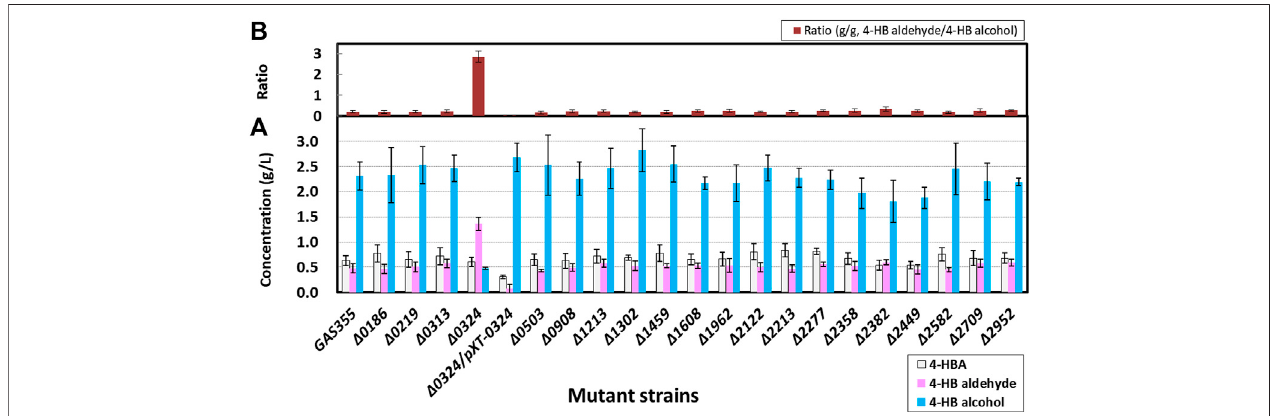
FIGURE 2 | Production of 4-hydroxybenzoate, 4-hydroxybenzaldehyde, and 4-hydroxybenzyl alcohol. (A) and the ratio of 4-hydroxybenzaldehyde to 4- hydroxybenzyl alcohol (B) by 20 in-frame deletion C. glutamicum mutants responsible for 4-hydroxybenzyaldehyde reduction in baf fl ed fl asks. The cells were grown in